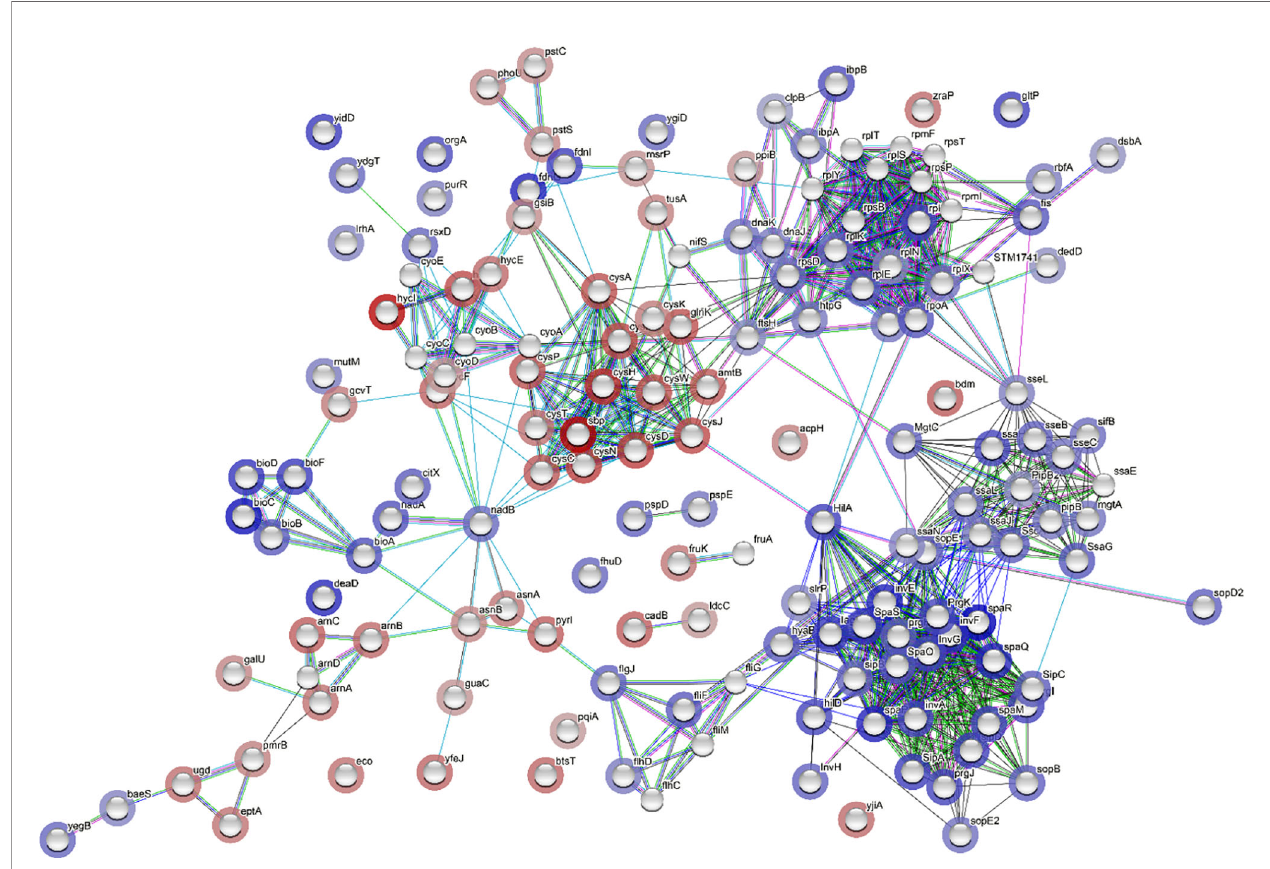
FIGURE 6 | Network analysis through STRING showing correlation between all differentially expressed genes (DEGs). Each network node represents the gene matched with a DEG. The color of the surrounding halo indicates the rank of the gene among all the DEGs, based on fold changes; blue means upregulated while red, downregulated. The interactions between the genes are marked by lines. Each color of the lines suggests a source of evidence to the association. Turquoise means known interactions from curated databases; pink means experimentally determined known interactions; green, red and dark blue means predicted interaction from gene neighborhood, gene fusions, and gene co-occurrence, respectively; yellow, black and purple indicates information was obtained from text-mining, co- expression, and protein homology,